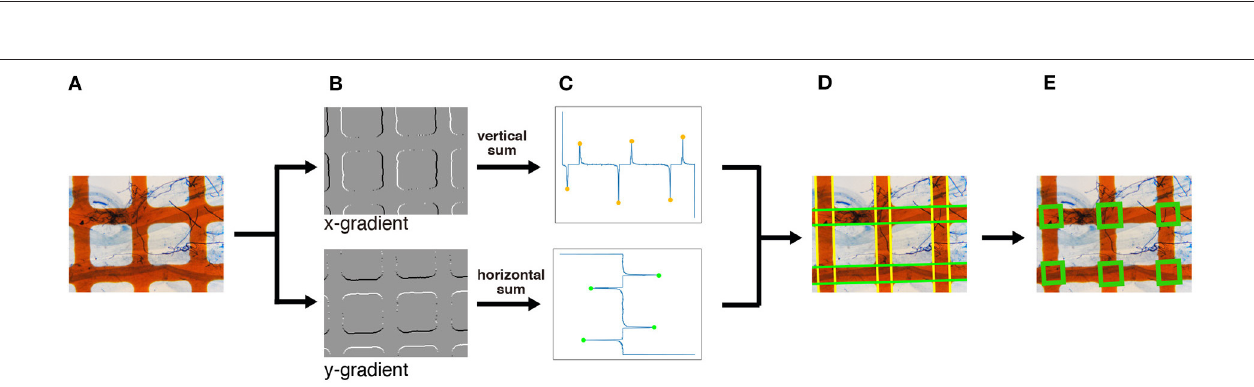
FIGURE 4 | An overview of the intersection detection process. (A) Input image. The normalized image generated in Figure 3 is used as the input. (B) Edge detection. The x - and y -gradients are calculated by applying the Sobel filters horizontally and vertically, respectively. (C) Peak detection using projection profiles. The detected edges in (B) are projected horizontally and vertically, and the peaks are detected. (D) Grid line detection. Based on the peaks obtained in (C) , the horizontal and vertical grid lines, denoted in green and yellow, respectively, are detected. (E) Intersection detection. The intersections, denoted by green rectangles, are finally detected. The magnification of the slide images was 40x.